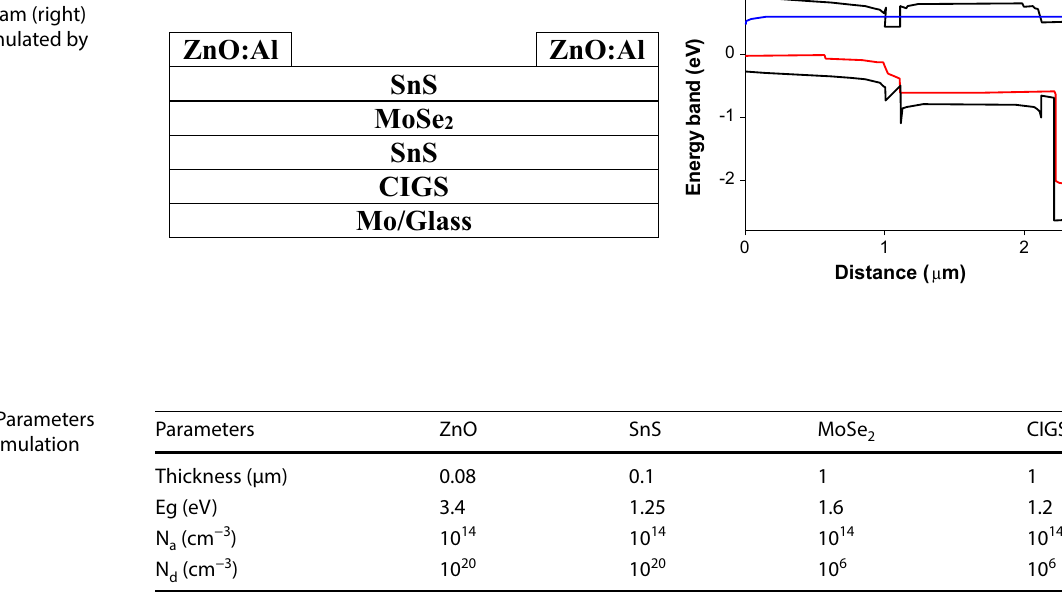
Fig. 1 Structure (Left) and the energy band diagram (right) of the solar cell simulated by using SCAPS-1D